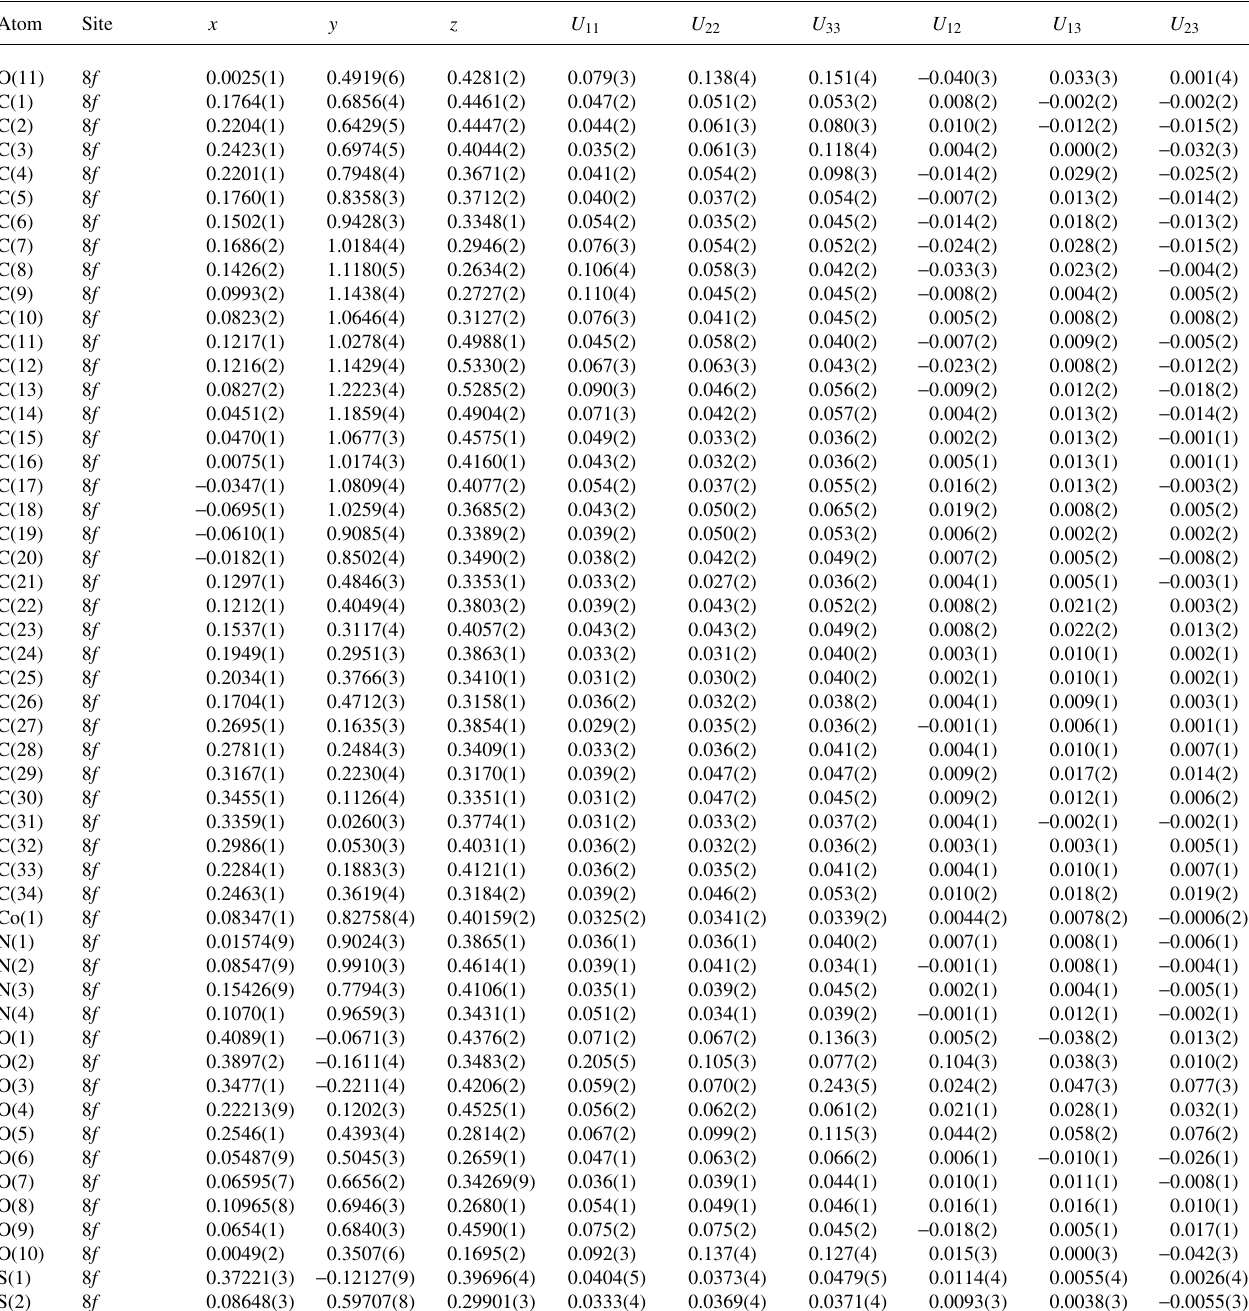
Table 3. Atomic coordinates and displacement parameters (in Å 2 )